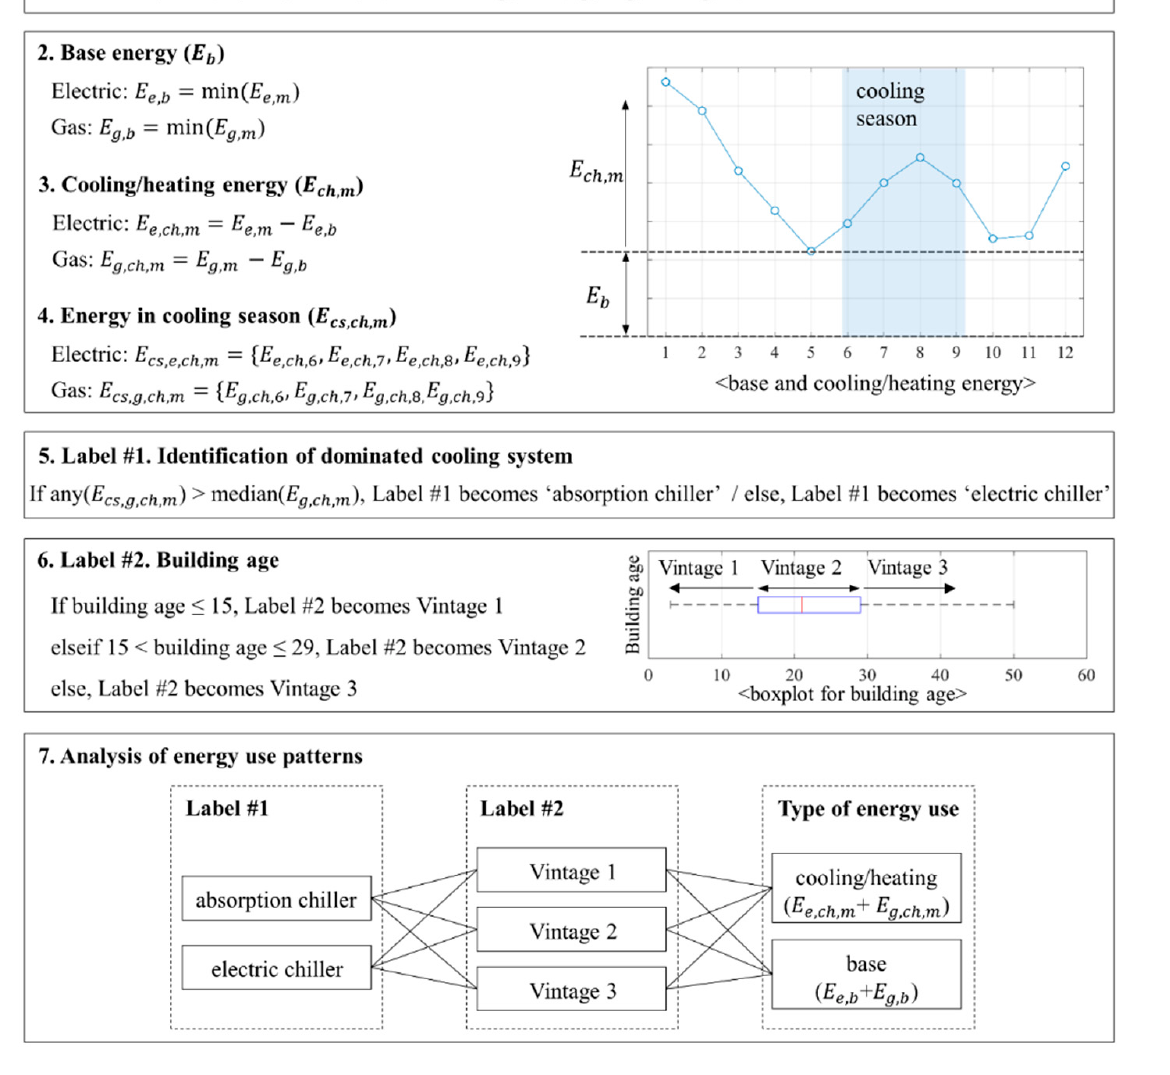
Figure 5. Monthly energy use analysis and categorization of building age and chilling system. The subscript m represents the month (January to December) from 1 to 12.